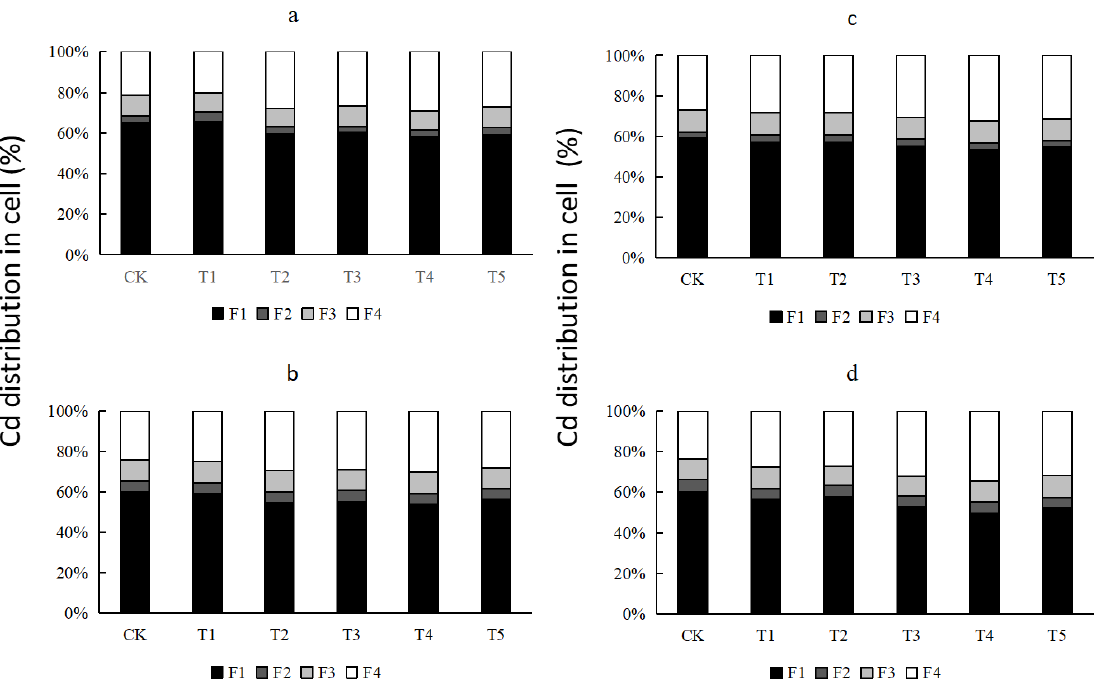
Figure 2. Subcellular distribution of cadmium in the leaves of Huayu 23 and Huayu 20. ( a ) Huayu 23 with high cadmium pollution; ( b ) Huayu 23 with low cadmium pollution; ( c ) Huayu 20 with high cadmium pollution; ( d ) Huayu 20 with low cadmium pollution. F1, F2, F3 and F4 are components of the cell wall, cell nucleus and chloroplast, mitochondria, and soluble cytoplasm, respec- tively.